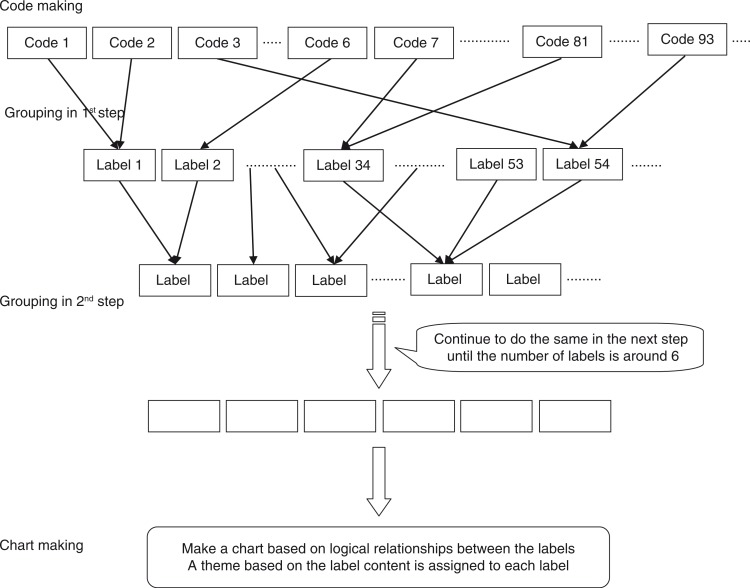
Analytical methods.